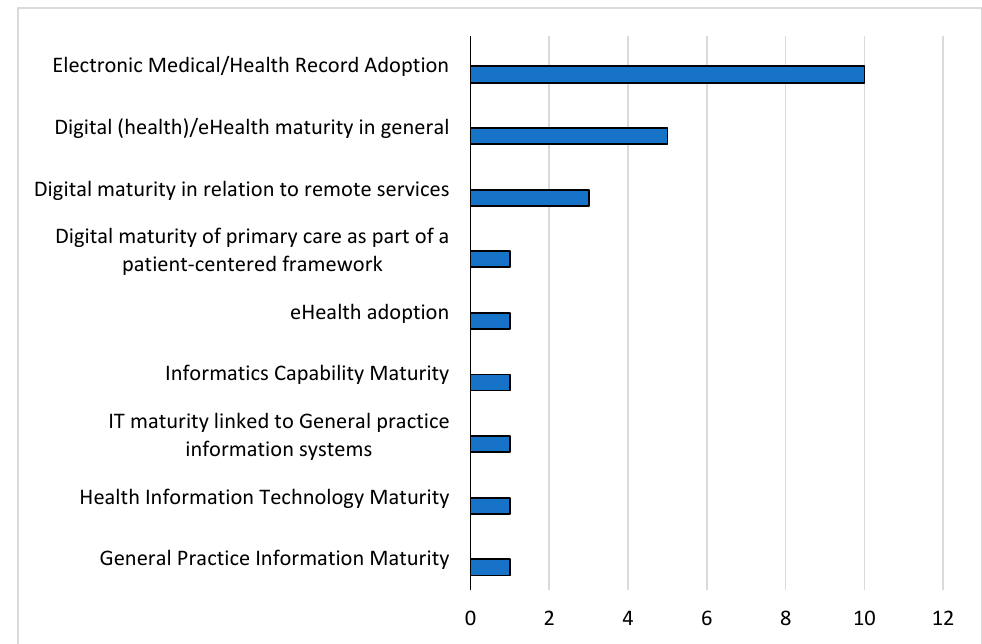
Figure 4. Context of digital maturity described by context categories.